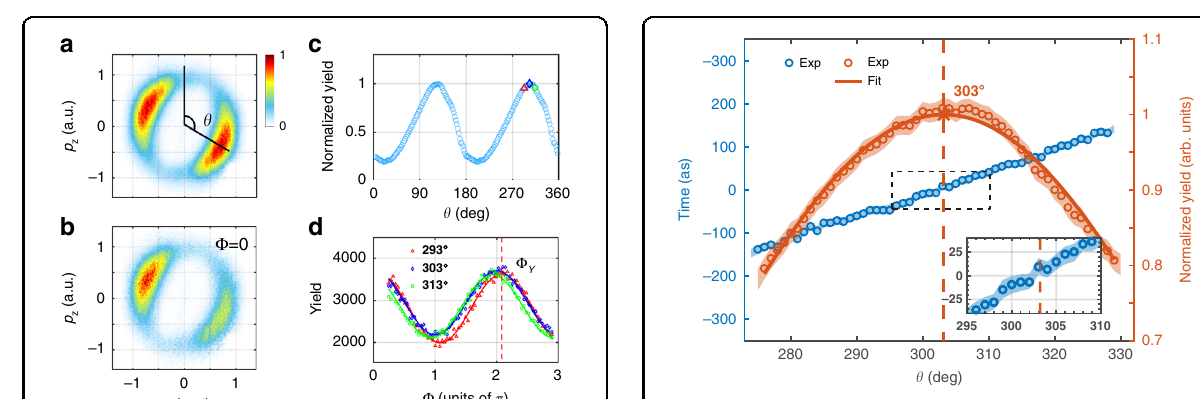
Fig. 3 Measured tunneling ionization time with respect to the electron emission angle. For comparison, the radially integrated PAD is shown by the red circles, which is fi tted with a Gaussian function (red solid curve) determining the peak of the PAD (vertical dashed line). The inset shows the enlarged view of the region inside the dashed frame. Note that zero time corresponds to the fi eld maximum of the elliptically polarized laser pulse. The experimental errors (shaded area) for the time show the 95% con fi dence interval for the fi tting process, and those for the photoelectron yield show the standard deviation of the statistical